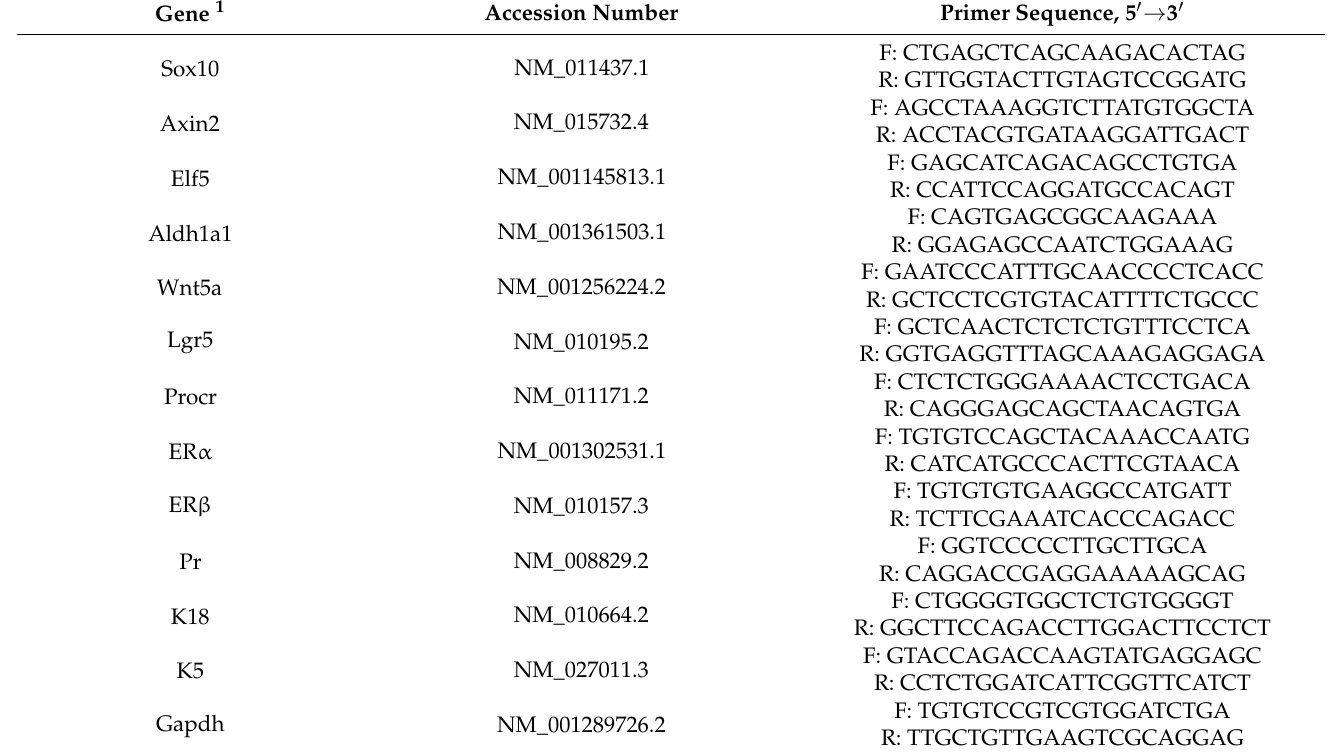
Table 1. Nucleotide sequences of real-time PCR